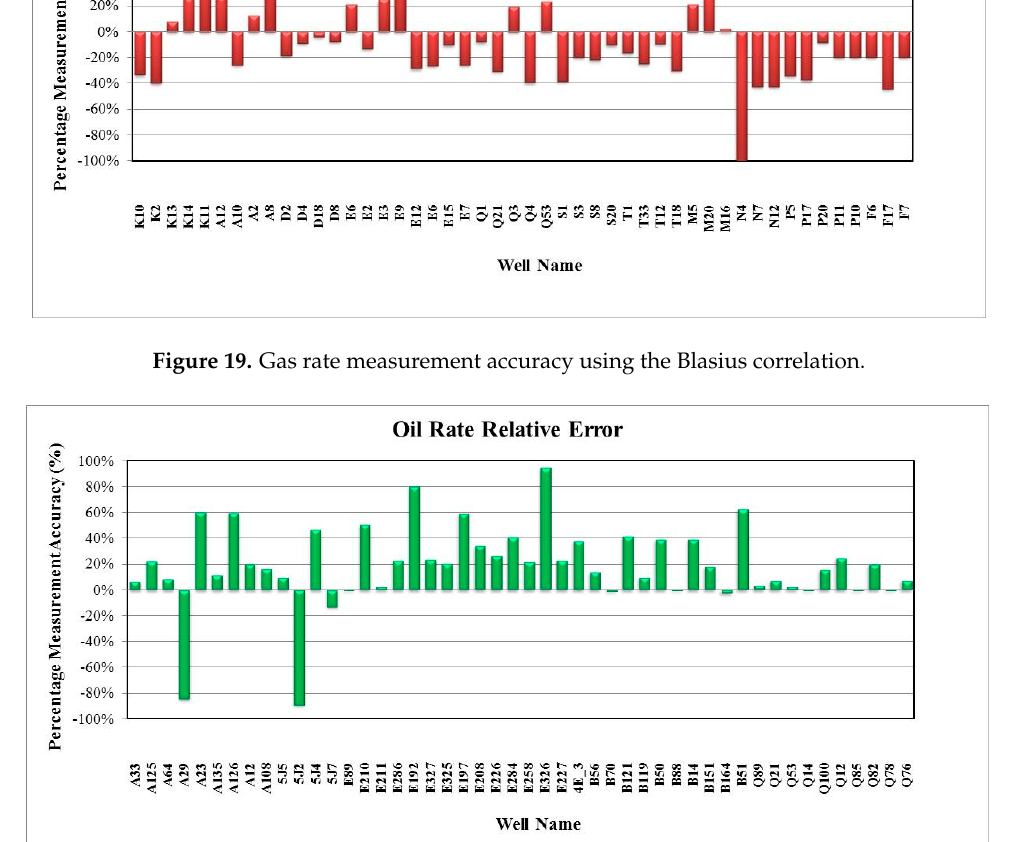
Figure 20. Oil rate measurement accuracy using the Darcy correlation.